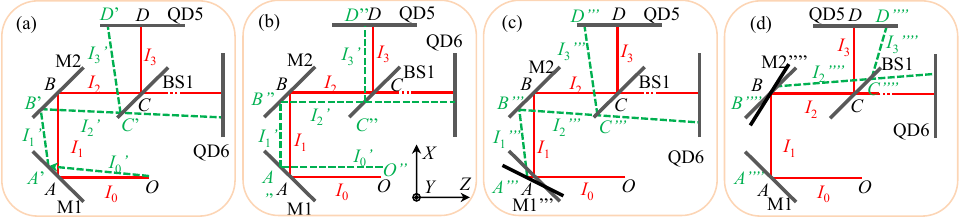
Figure 7. Outputs of QD5 and QD6 caused by ( a ) the angular drift, ( b ) the linear drift, ( c ) the rotation of M1 and ( d ) the rotation of M2.